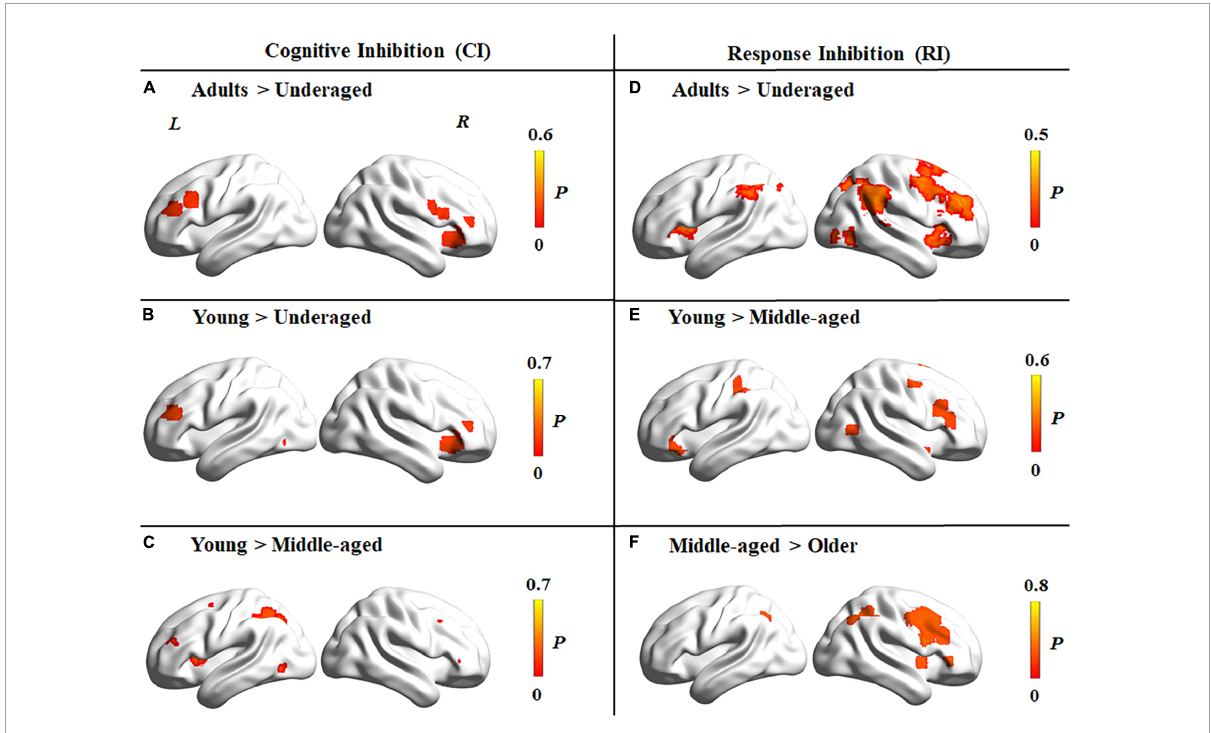
FIGURE5 Brain activation differences among four age groups for tasks tapping cognitive inhibition and response inhibition. (A–C) Brain activation differences in cognitive inhibition. (A) Higher activation in adults than under-aged children group. (B) Higher activation in young than under-aged children. (C) Higher activation in young than middle-aged adults. (D–F) Brain activation differences in response inhibition. (D) Higher activation in adults than under-aged children group. (E) Higher activation in young than middle-aged adults. (F) Higher activation in middle-aged than older adults. The color bar represents the maximum proportion of studies exhibiting the effect at the peak density weighted by sample size